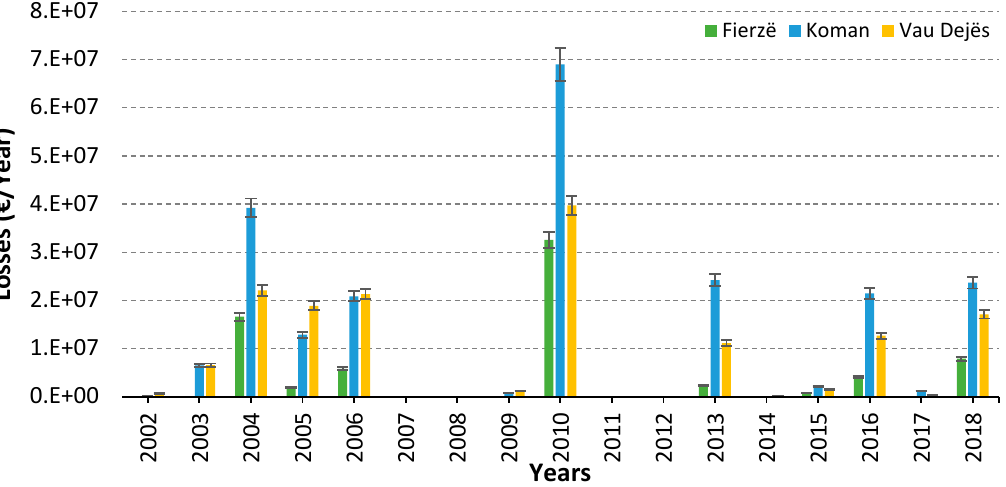
Figure 2. Level of potential financial losses (EUR/year) in the Drin River cascade, during 2002–2018.